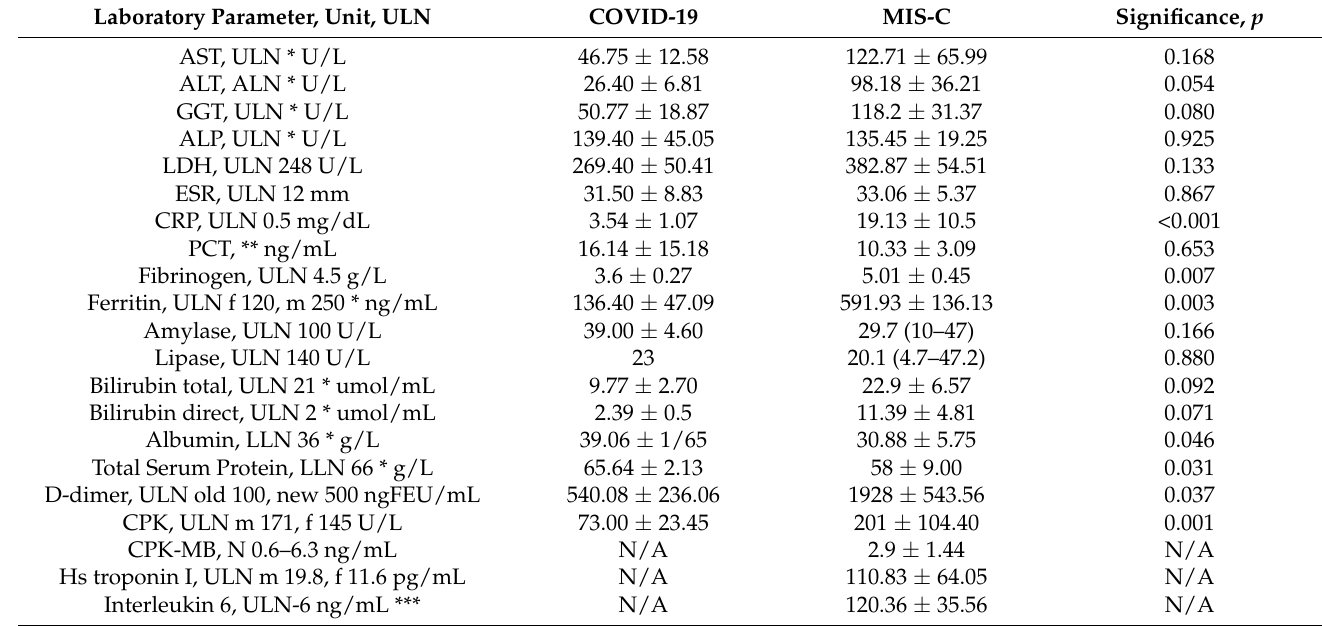
Table 2. Comparison of laboratory findings in children with COVID-19 infection and those with MIS-C. Data are presented as mean ±